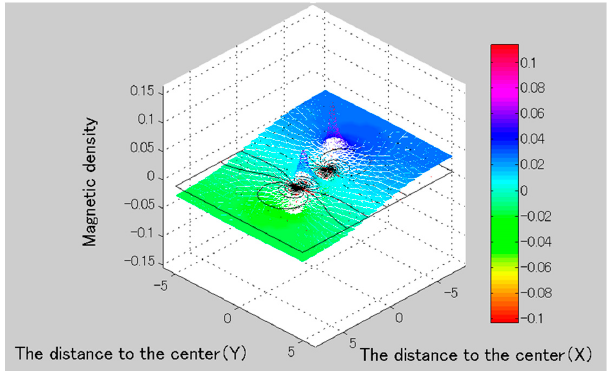
Figure 10. Simulation results of the magnetic flux density.